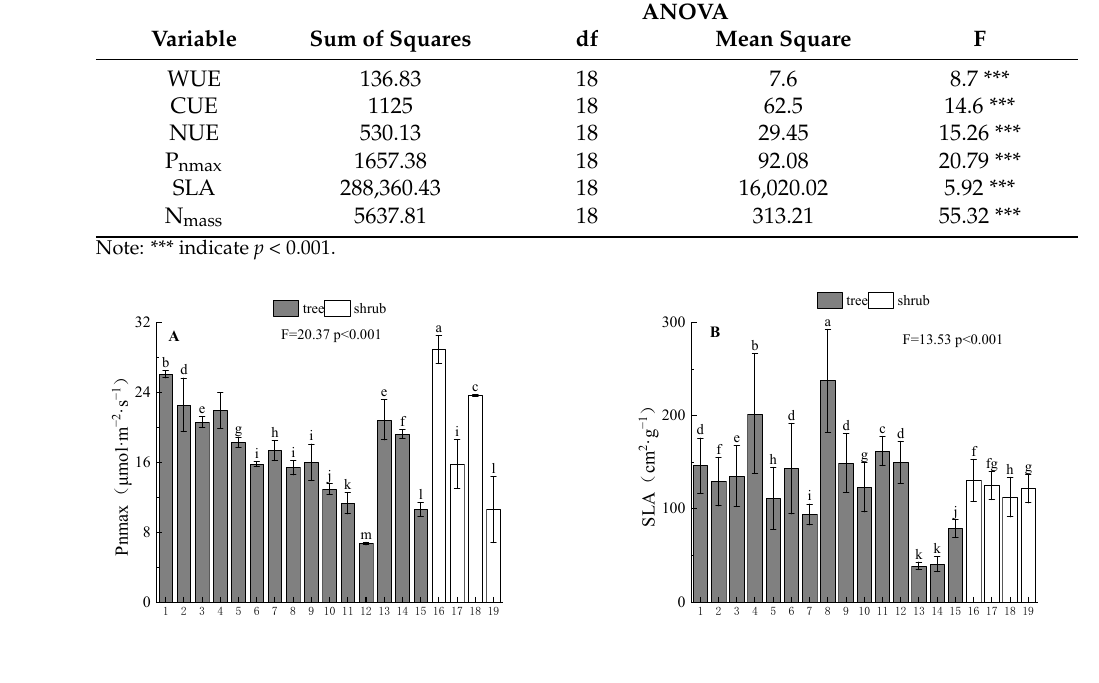
tree shrub F=8.7 p<0.001